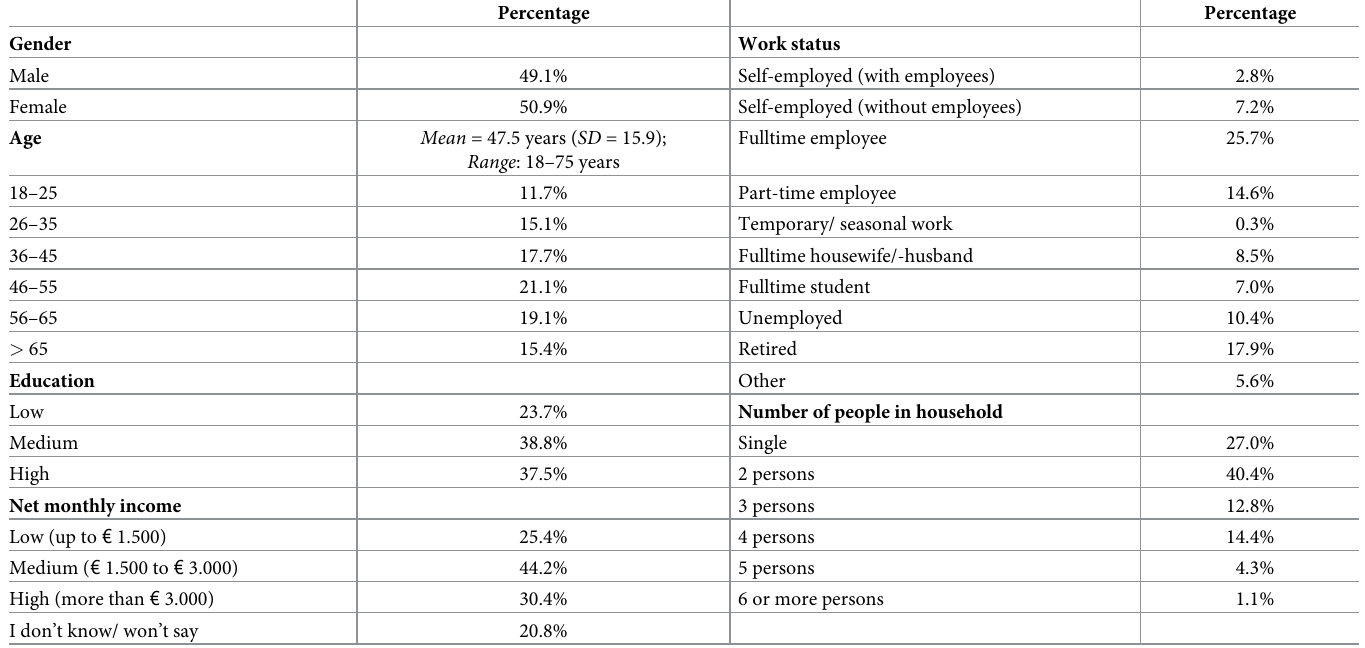
Table 1. Sample characteristics (N =